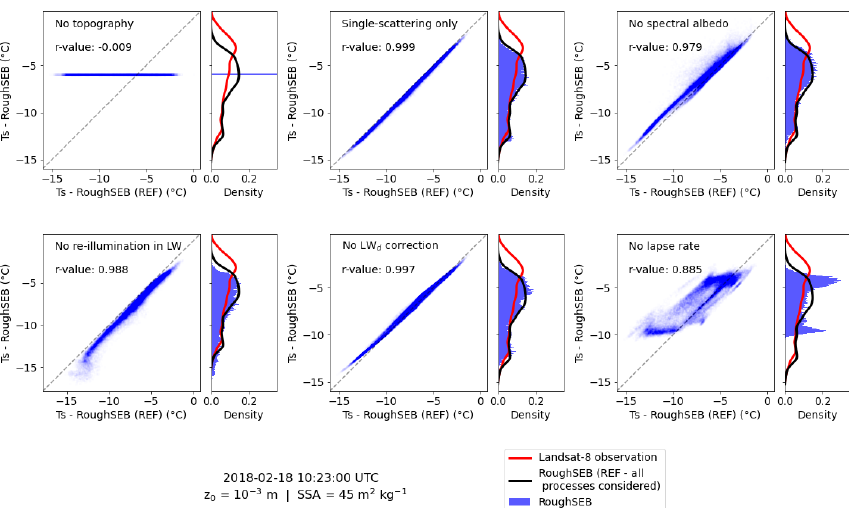
Figure 9. Impact of disabling a topographic effect on the simulated T s on 18 February 2018. Each panel corresponds to a disabled topographic effect, with respect to the reference simulation (REF) where all the effects are included. The marginal histograms show the distribution of surface temperature for each simulation as well as the observed T s by the satellite (red) and the reference simulation (black).